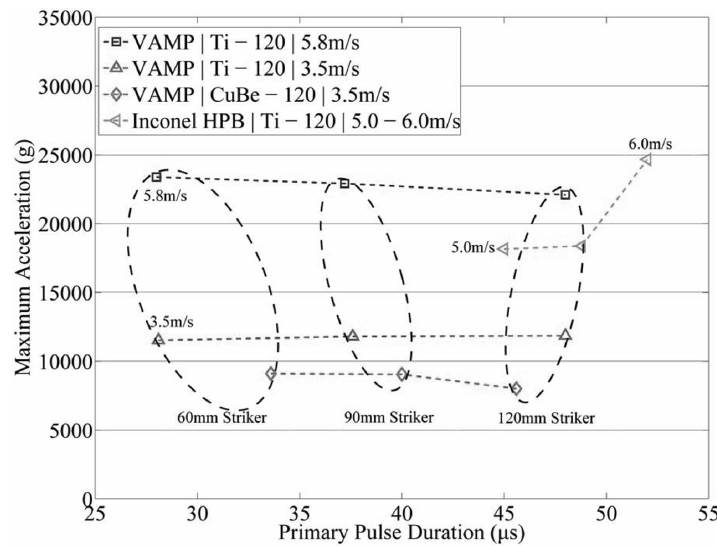
Fig. 9. Acceleration pulse range for each experimental method in terms of acceleration magnitude and primary pulse duration. The broken lines between data points represent an indicative curve-fit.